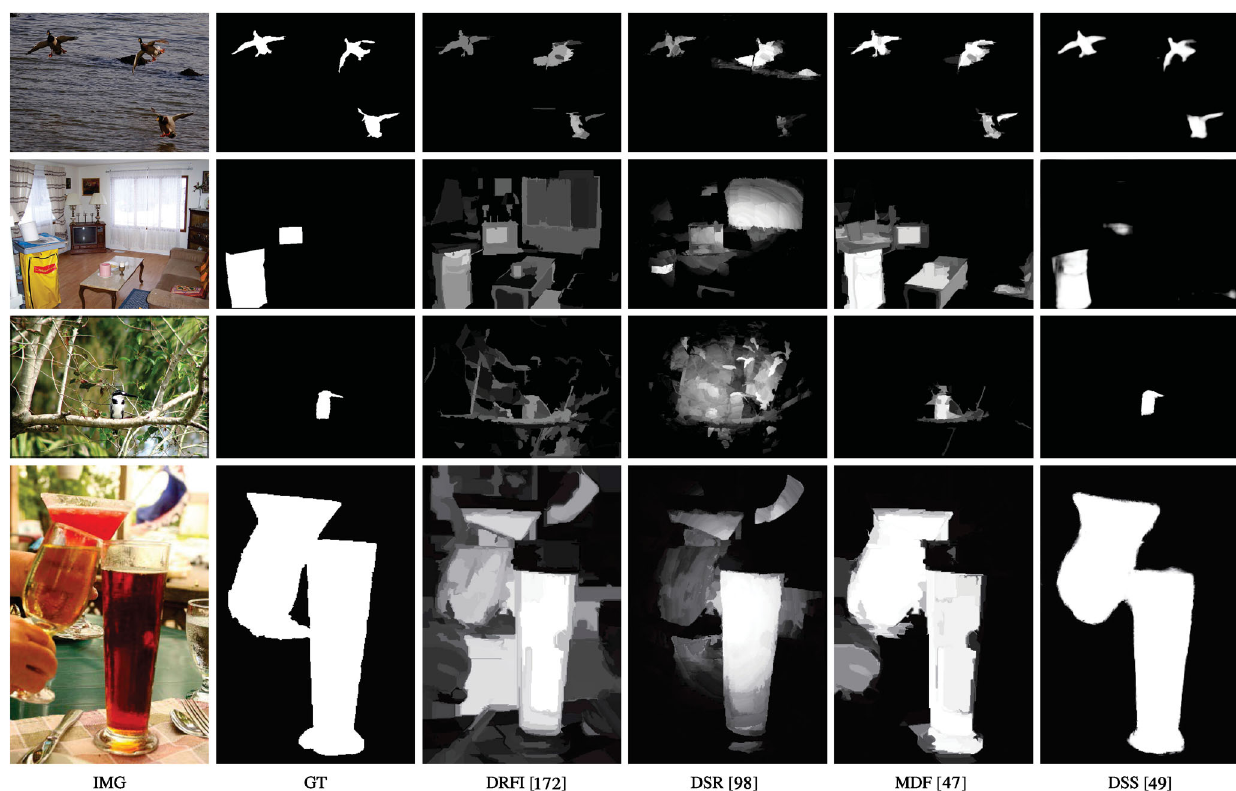
Fig. 5 Visual comparisons of two best classic methods (DRFI and DSR), according to Ref. [132], and two leading CNN-based methods (MDF and